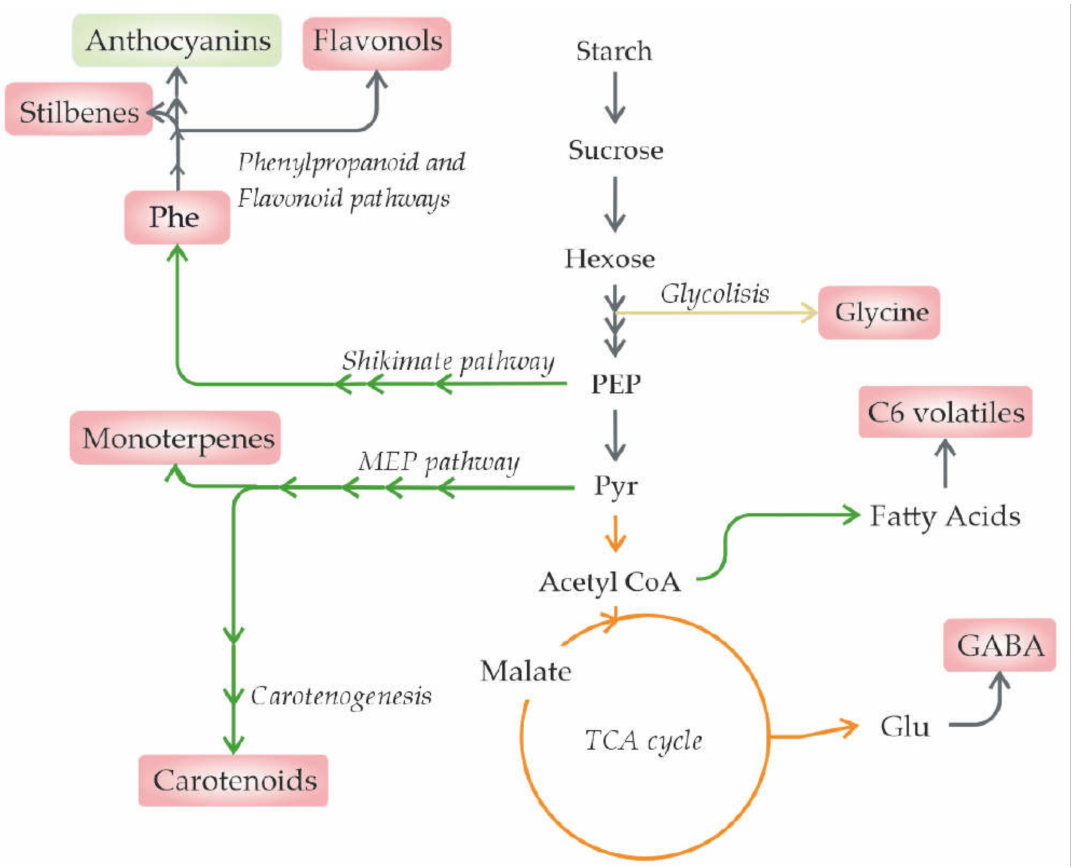
Figure 3. General effects of an increase of irradiance in fruit metabolism. Red: increase; blue: decrease; and green: changes in its patterns. Arrows: grey: cytosol; orange: mitochondria; green: plastids; and yellow: